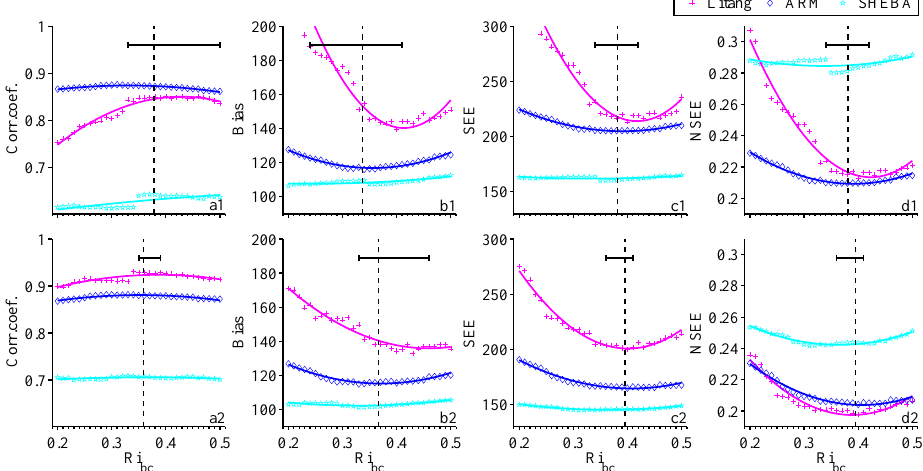
Figure 10. Comparison between estimated PBLHs using the bulk Richardson number method with z s = 0 . 1PBLH (upper panels) and z s = z SAL (lower panels) and observed PBLHs for UBLs. The correlation coefficient (a) , bias (b) , standard error (c) , and normalized standard error (d) are shown. The sounding data are taken from Litang (plus sign), ARM Shouxian (diamond), and SHEBA (pentacle). The curved lines are obtained by quadratic curve-fitting, the black vertical dashed lines indicate a representative Ri bc for all three sites, and the error bars indicate the range of Ri bc across the three sites. Table 2. Inferred bulk Richardson number of the entire PBL, Ri bc , for different types of PBLs and sites, with different values of z s . n refers to the sample number. ∗ indicates the best choice. z s (m)